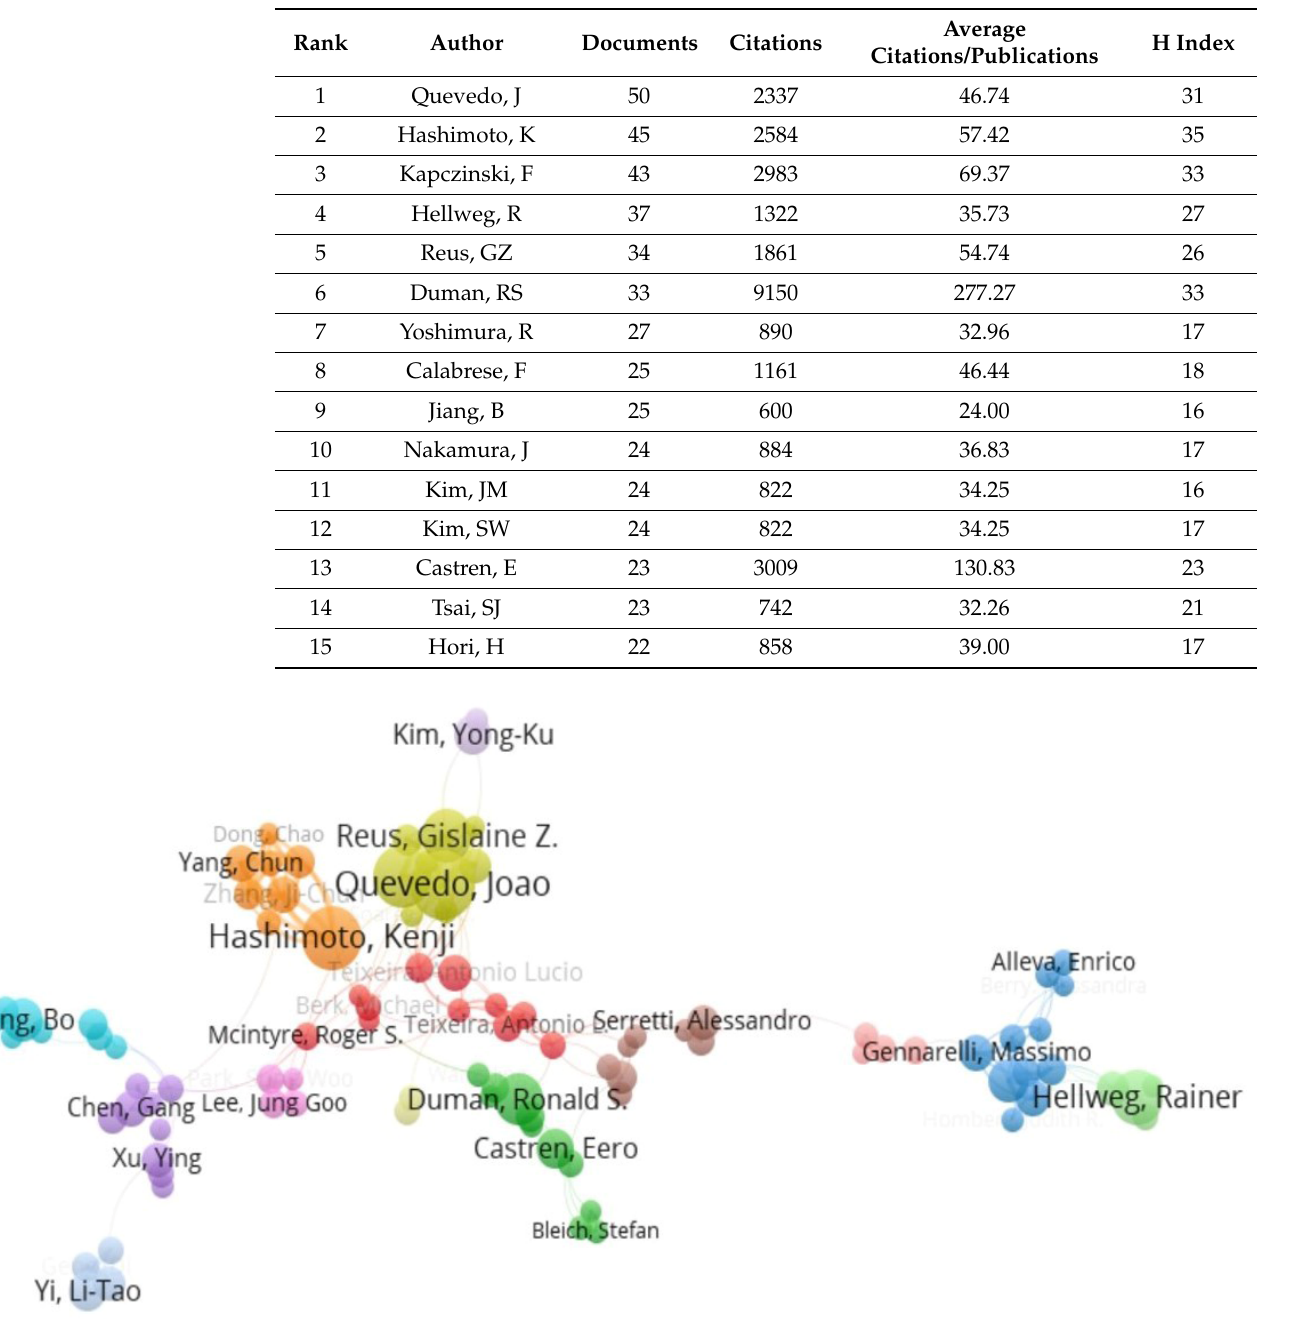
Figure 3. Contributions of authors. Mapping of the co-authorship analysis among the authors who published at least 10 papers on the association between depression and BDNF according to VOSviewer. In the figure, the node sizes represent the volume of published literature, the larger the node, the greater the volume of published literature; the lines represent the association strength, the thicker the line, the stronger the connection between the two authors; the node colors represent different